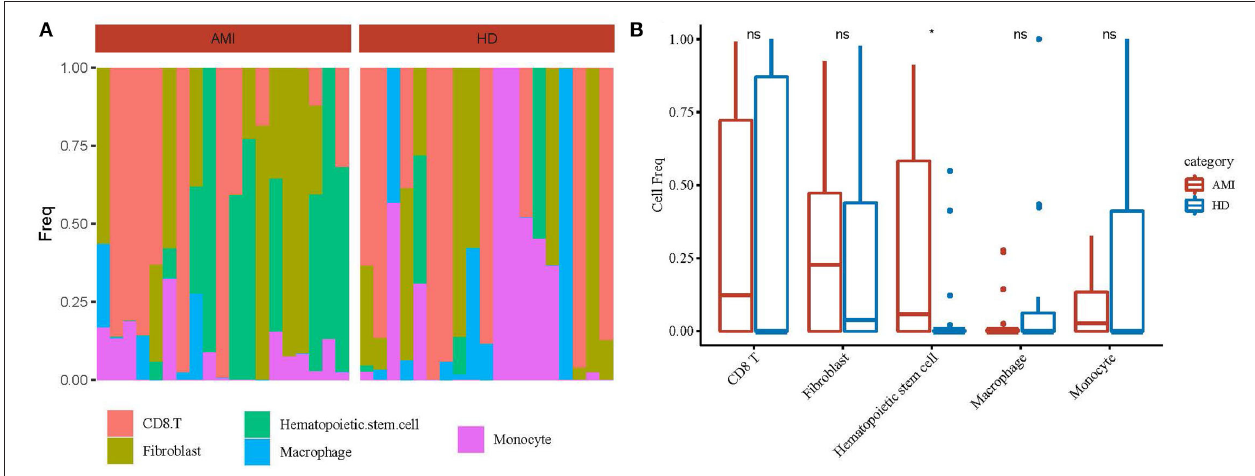
FIGURE 2 | Identification of differential cell subsets. (A) The abundance of the 5 identified cell types in acute myocardial infarction (19 cases) and healthy tissues (19 cases) from the GSE109048 dataset by the CIBERSORT method. (B) A statistical chart of 5 identified cell types in in acute myocardial infarction (AMI) and healthy tissues. * p < 0.05; ns, no